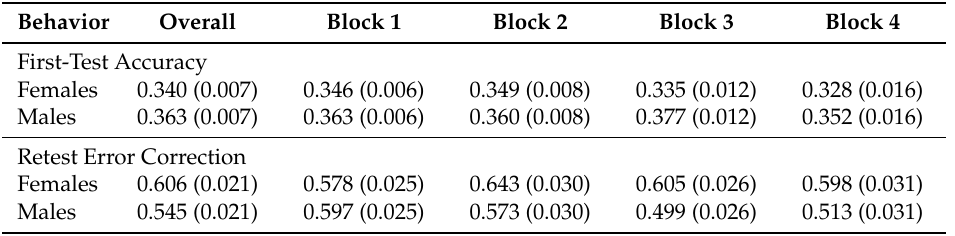
Table 2. Memory Performance. Proportion correct at first-test and retest as a function of gender and block. Means are adjusted for BDI-II, Brooding, and Reflection covariates.